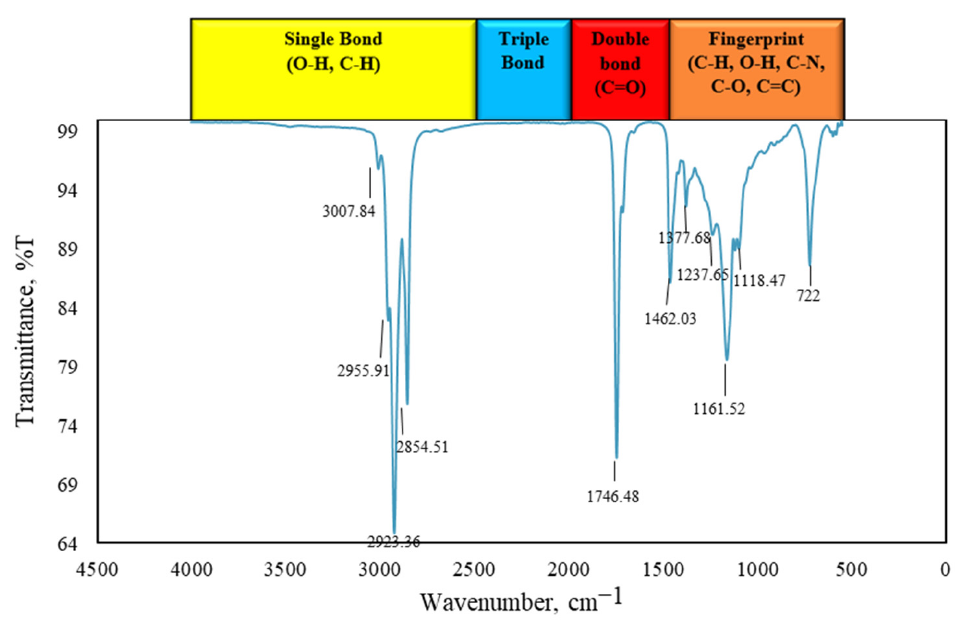
Figure 11. Wavenumber of Malaysian Jatropha seed oil from FTIR band.